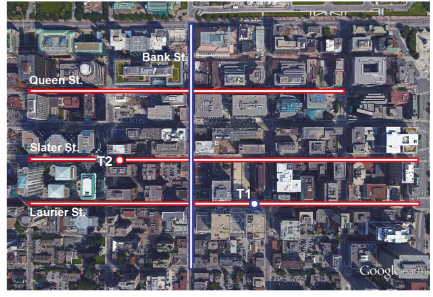
Figure 11: Downtown Cali City, Colombia, from Google Earth.